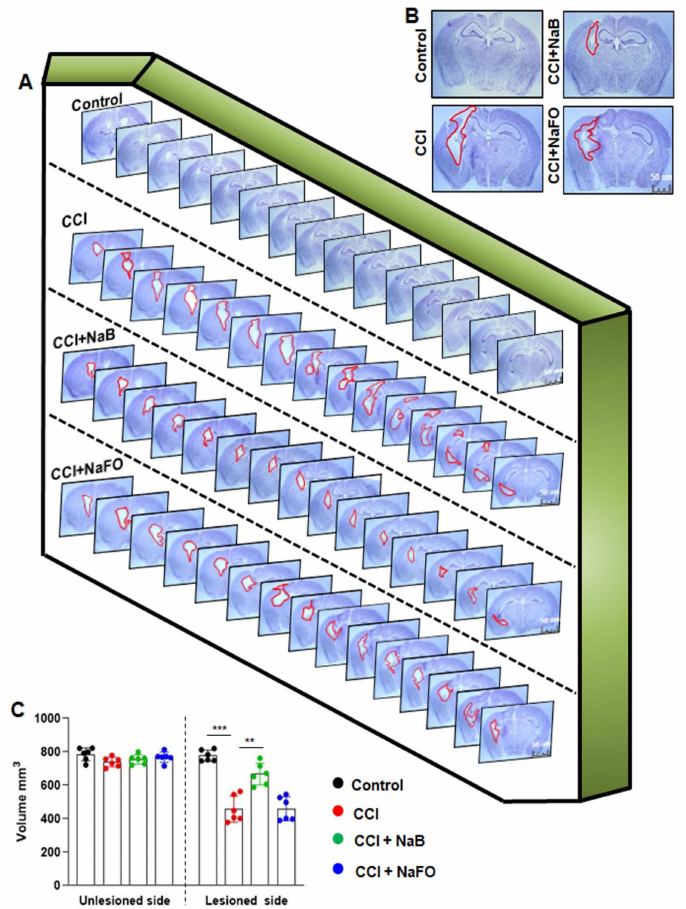
Figure 4. NaB treatment reduces the lesion volume in mice with CCI injury. ( A ) Representative cresyl violet sections of mouse brain arranged in series of the hippocampal region show the volume of the lesion cavity in different groups. ( B ) Illustrative images of cresyl violet sections are shown. Note the extent of damage induced in the brain was found to be reduced in NaB-treated mice when compared to CCI mice without treatment and NaFO-treated CCI injury mice. ( C ) Lesion size was quantitatively measured in control mice, untreated CCI-injured mice, NaB-treated CCI mice and NaFO-treated CCI mice at 21 days post-injury. Statistical analyses were performed with two-way ANOVA and are expressed as mean ± SD to compare the lesion volume between unlesioned and lesioned sides of the brain, as [F 1,20 = 156.60 (*** p < 0.0001] control vs. CCI, and [F 3,20 = 30.23 (** p < 0.001) CCI vs. CCI+NaB treatment,